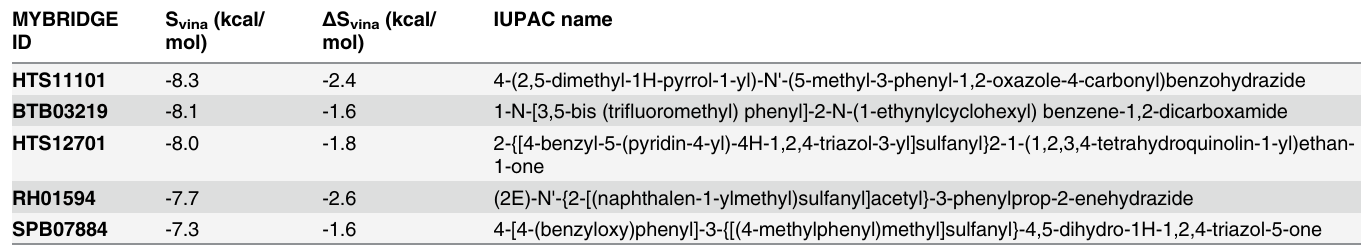
Table 2. Vina score, IUPAC name and MYBIDGE-HitFinder identifier for five selected compounds. MYBRIDGE ID